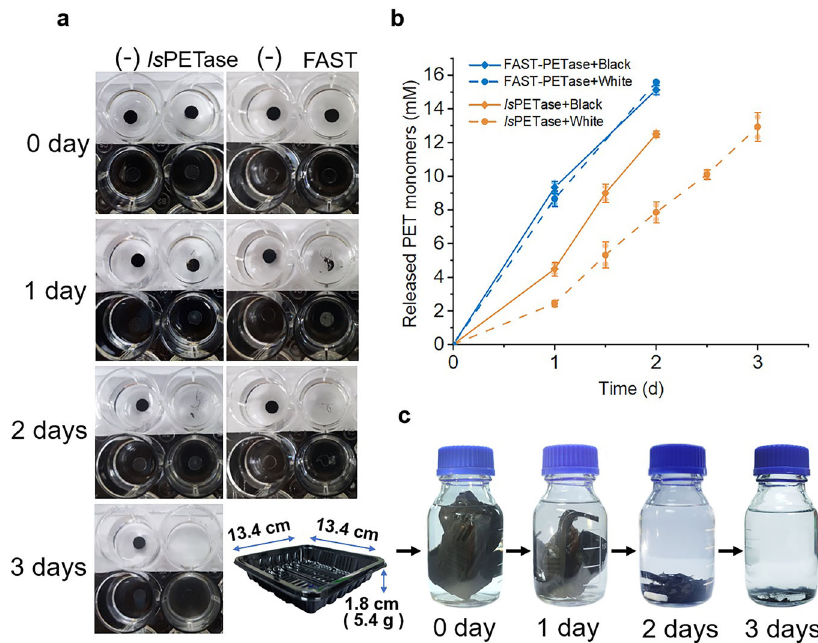
Fig. 6 Depolymerization of the raw, untreated postconsumer-PET. a Degradation of raw, untreated PET fl akes with Is PETase- Pp and partial-deglyco FAST-PETase- Pp at 50 °C. b Time course of PET monomers released from the fl akes during the digestion with partial-deglyco Is PETase- Pp and partial- deglyco FAST-PETase- Pp . c Degradation of an untreated PET tray with partial-deglyco FAST-PETase- Pp at 50